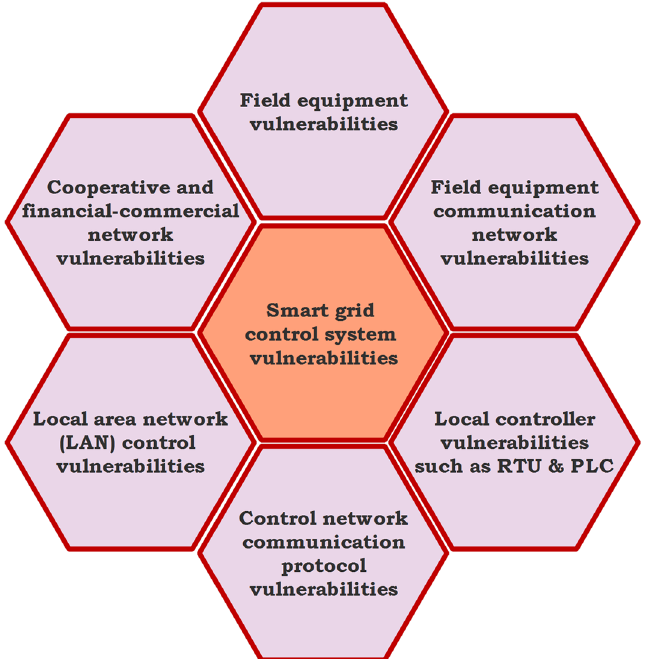
Figure 9. Control system vulnerabilities in smart grid.